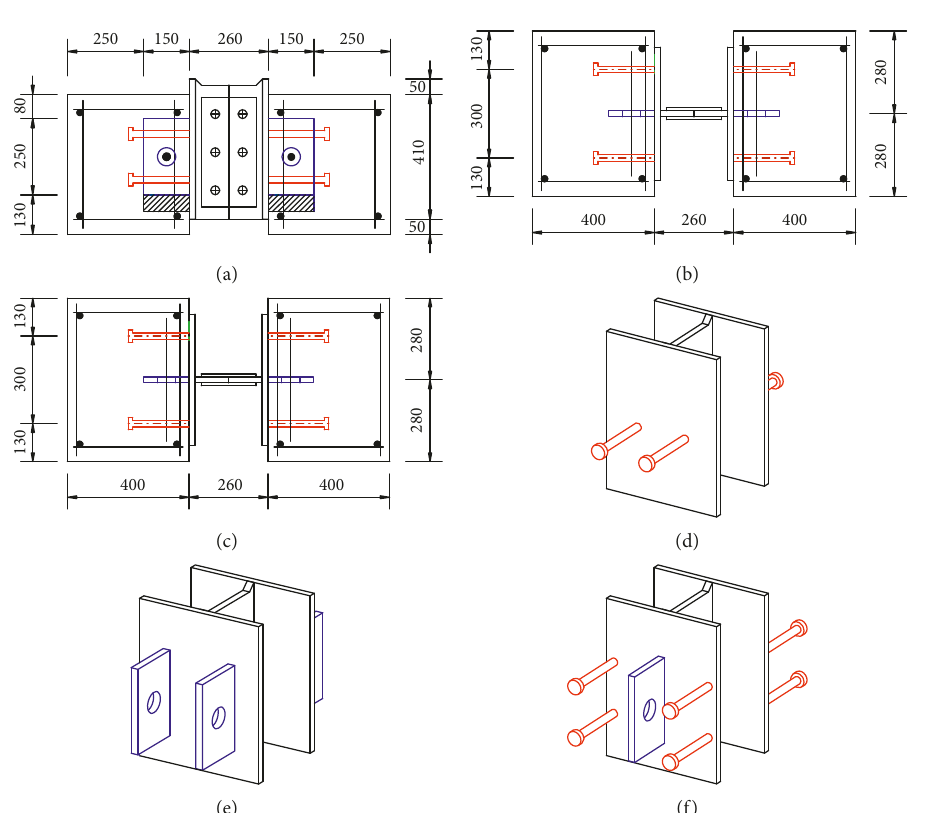
Figure 1: Layout of the push-out test specimen. (a) Front view. (b) Top view. (c) Side view. (d) Headed stud connector. (e) Perfobond rib connector. (f) Mixed shear connector.